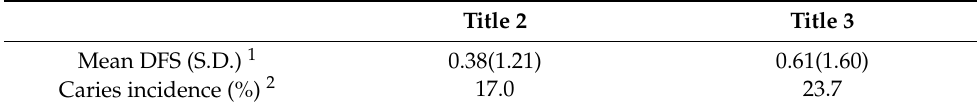
Table 2. Descriptive analysis of the caries increment of the first permanent molars over a 24-month study course.